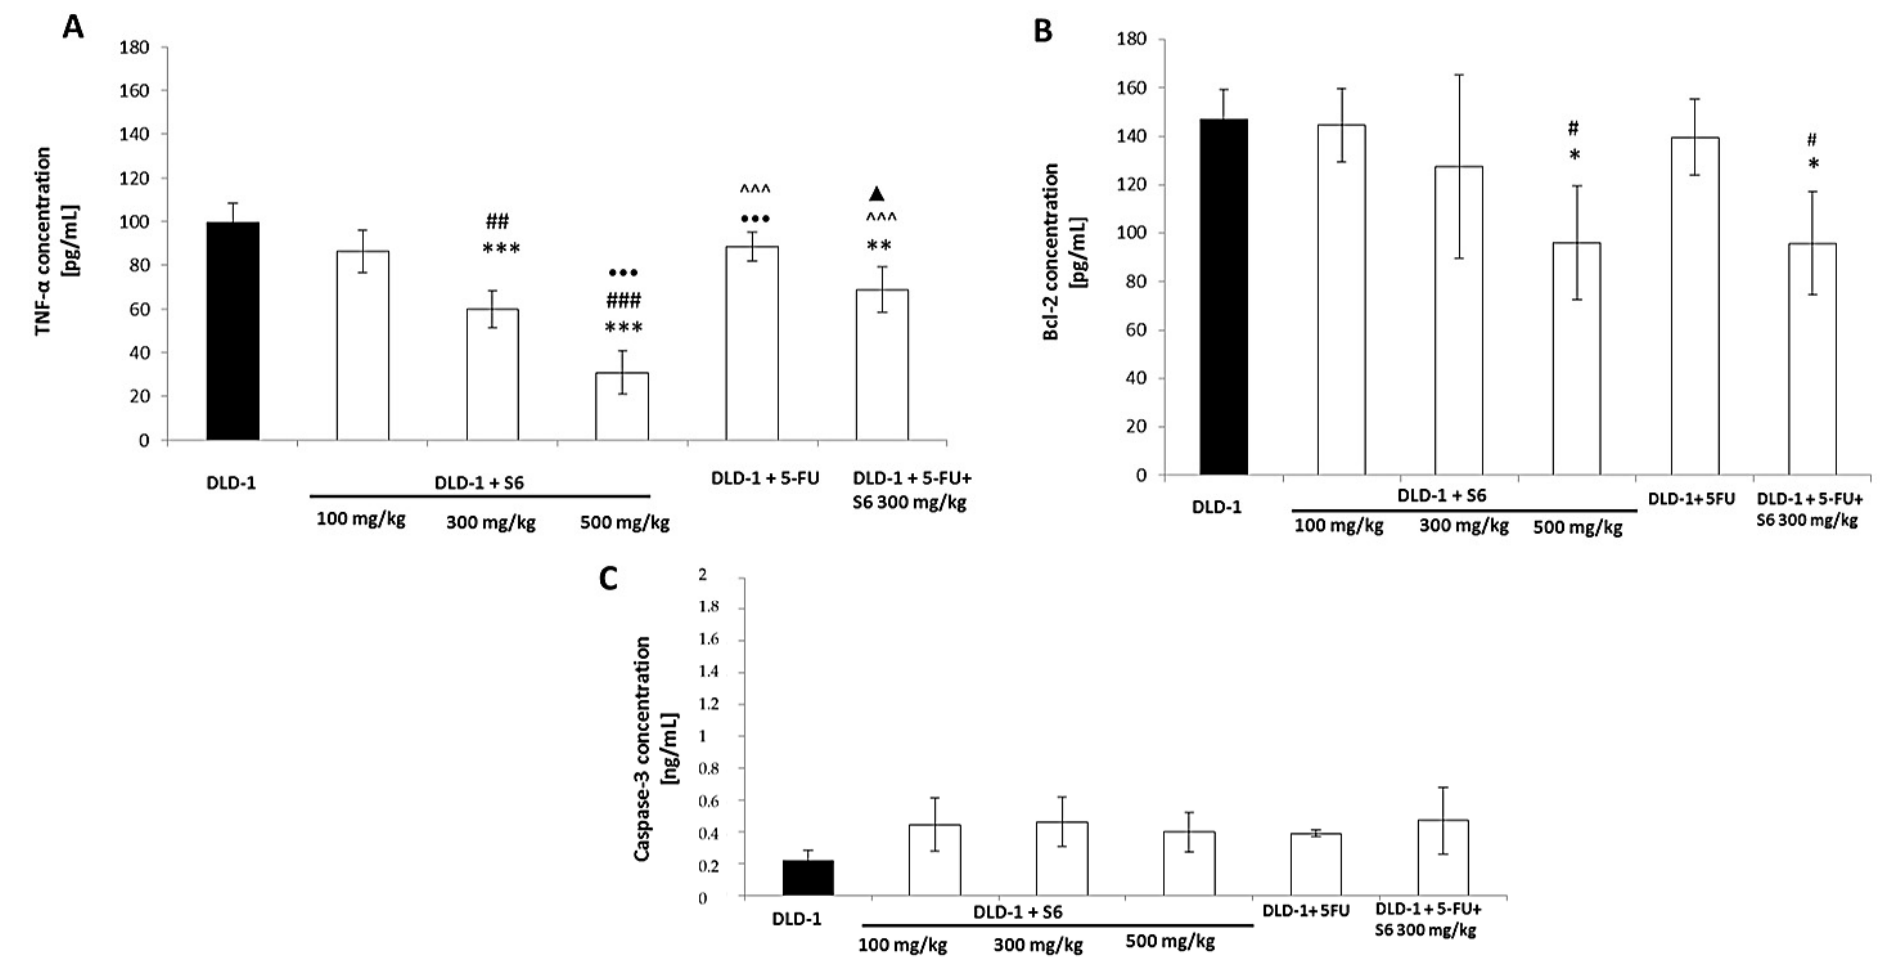
Figure 4. TNF- α ( A ), Bcl-2 ( B ), and caspase-3 ( C ) concentrations in the serum of mice from experimental groups. The results are expressed as the mean ± SEM for each group. * p <0.05, ** p < 0.01 and *** p < 0.001 compared with the DLD-1 group; # p < 0.05, ## p < 0.01, and ### p < 0.001 compared with DLD-1 + S6 100 mg/kg; ••• p < 0.001 compared with DLD-1+ S6 300 mg/kg; ˆˆˆ p < 0.001 compared with DLD-1 + S6 500 mg/kg; (cid:78) p < 0.05 compared with DLD-1+